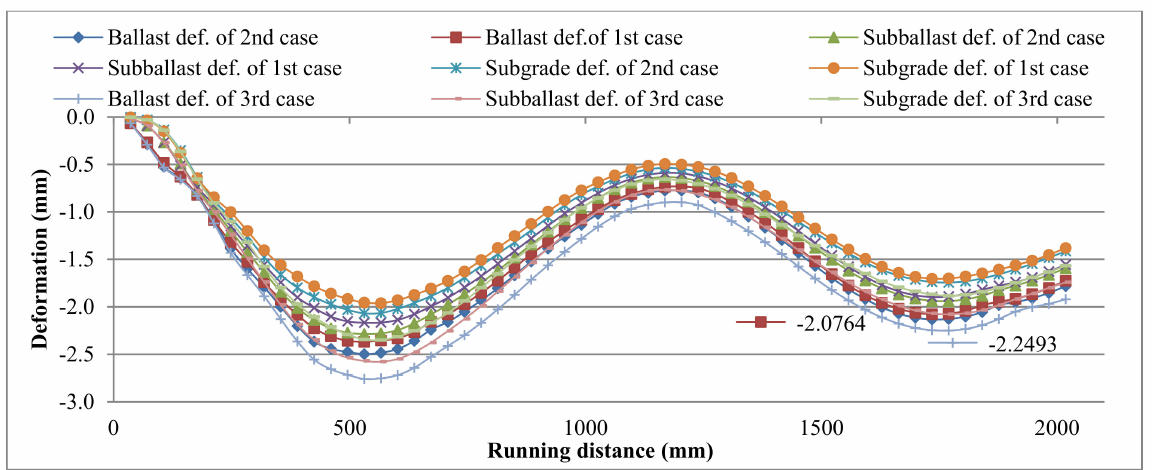
Figure 16. Substructure deformation